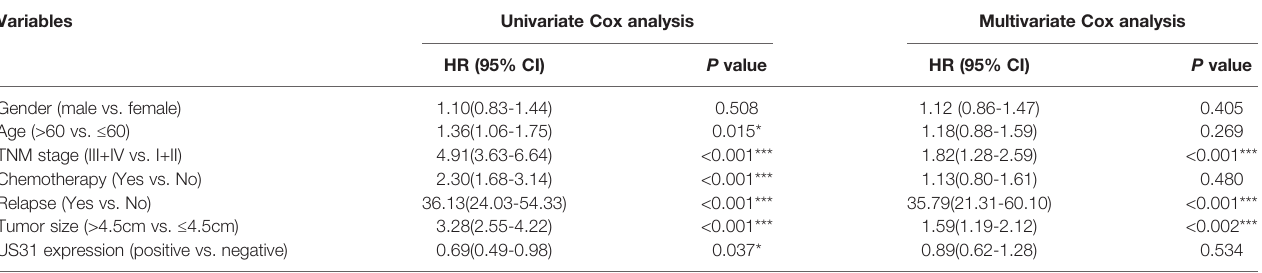
TABLE 3 | Univariate and multivariate Cox regression analysis of overall survival in patients with gastric cancer. Variables